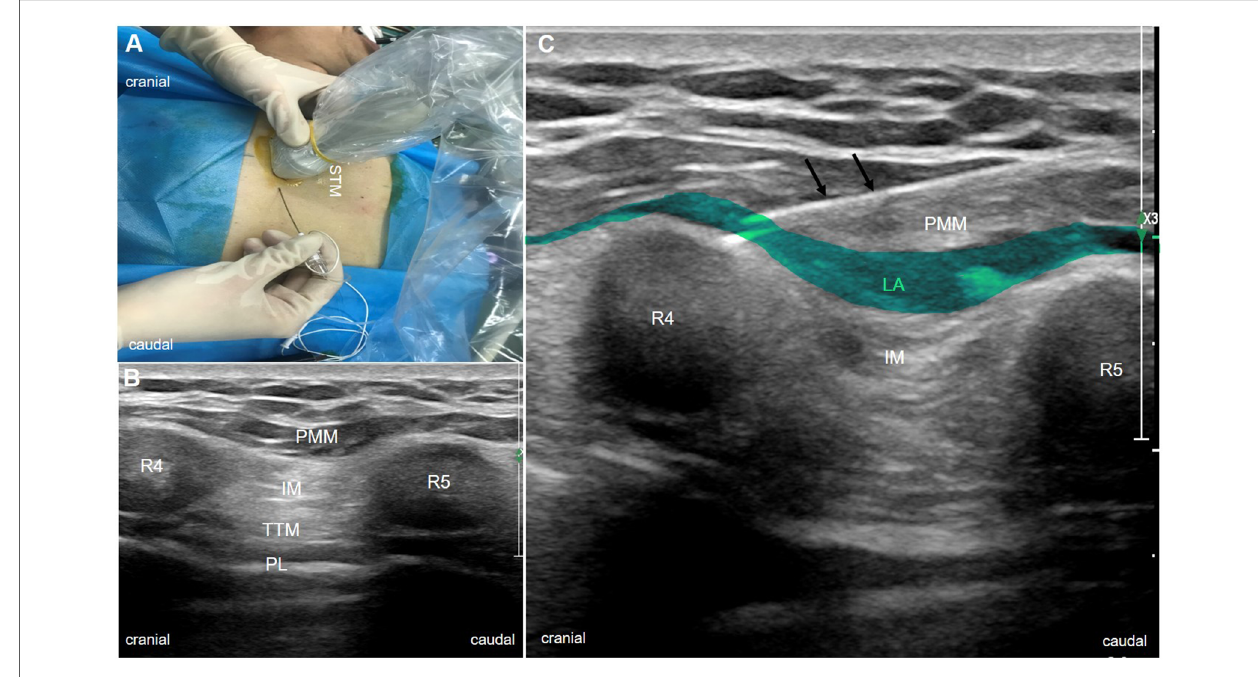
FIGURE 1 Procedures of PIFB. ( A ) patient positioning, longitudinal transducer, and needle orientation during PIFB. ( B ) anatomical location of PIFB on ultrasound (between the fourth and fi fth ribs beside the sternum). ( C ) dissemination of local anesthetics with the movement of a needle (arrow). IM, intercostal muscle; LA, local anesthetics; PIFB, pecto-intercostal fascial block; PL, pleura; PMM, pectoralis major muscle; R4, fourth rib; R5; fi fth rib; STM, sternum; and TTM, transversus thoracis